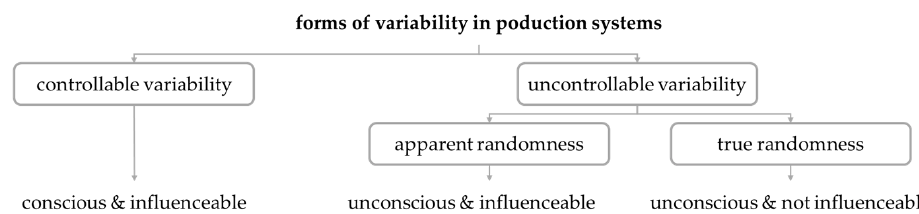
Figure 1. Forms of variability (and randomness).